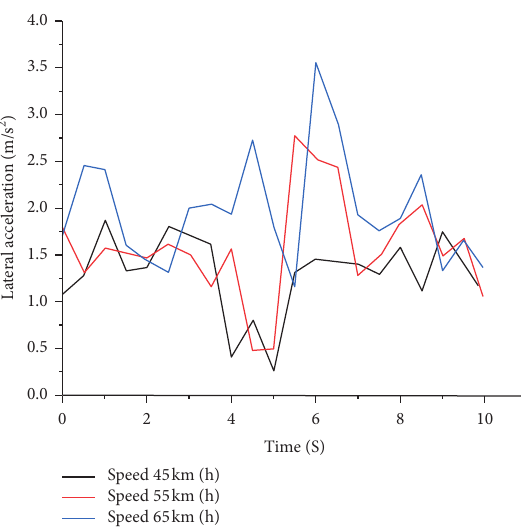
Figure 9: Lateral acceleration change of the accelerated lane changing scenarios.